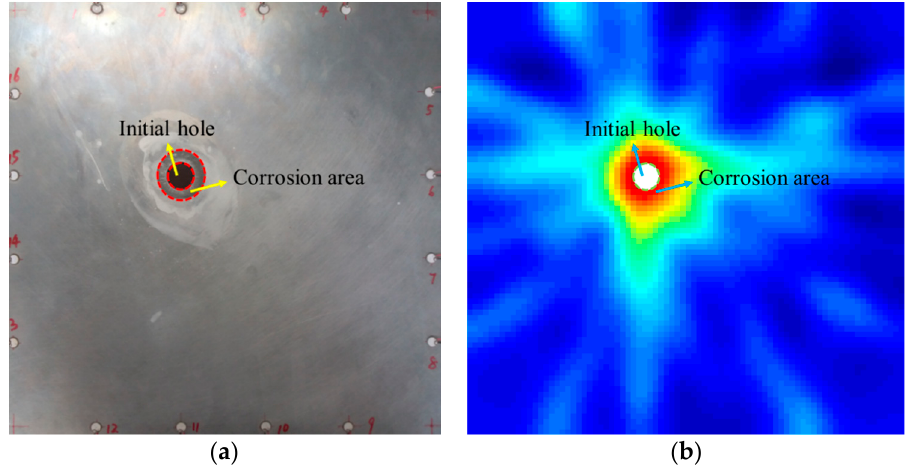
Figure 15. ( a ) The area of real corrosion damage and ( b ) the area of predicted corrosion damage.